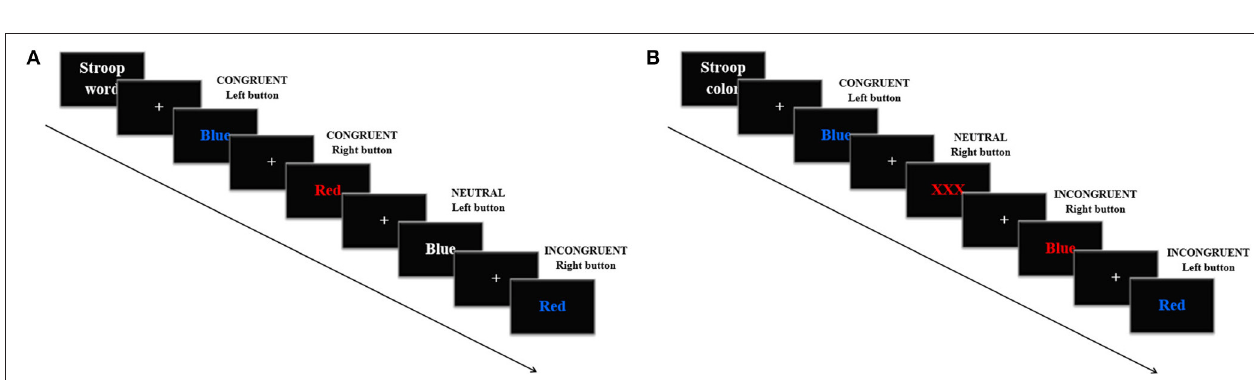
FIGURE 2 | Example of four trials in the Strop task. Every trial appeared every 1.5 s. In the Stroop word (A) , participants were told to press the left mouse button when the word “Blue” was presented and the right one when the word “Red” was presented. In the Stroop color (B) , participants were asked to press the left mouse button when the letters were written in blue and the right one when the letters were written in